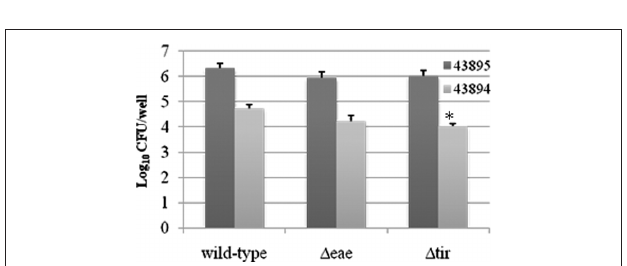
were quantified after PBRE cell-lysis with 0.1% (v/v) Triton X-100. (B) Intracellular bacteria were quantified after gentamicin treatment for 2 h. Results are expressed as cell-associated or intracellular bacteria relative to those obtained without inhibitor, taken as 100%. Each value is the mean of three separate experiments.